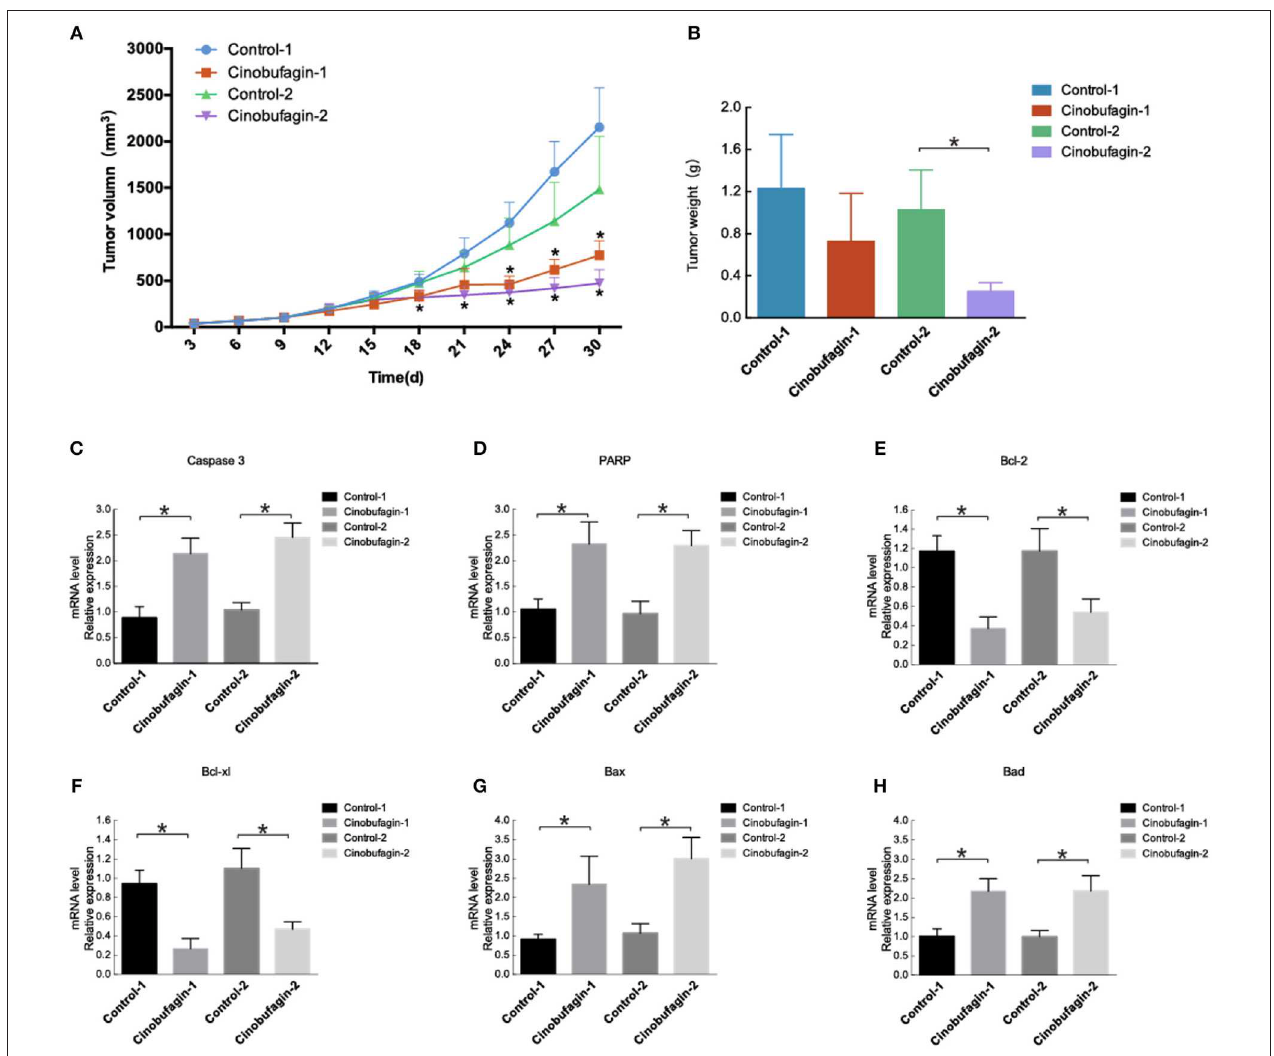
FIGURE 6 | Cinobufagin modulates tumor growth and apoptosis. (A) Nu/Nu nude mice were injected with OCM1 cells. After the tumor size reached 100 mm 3 , the experimental group was intraperitoneally injected with cinobufagin at 5 mg/kg once a day for 10 days (cinobufagin 1). The control group (control 1) was intraperitoneally injected with 0.5 mg/kg saline for 10 days. After the remaining 10 mice had tumors up to 300 mm 3 , the tumors were injected with cinobufagin at 5 mg/kg once a day for 7 days (cinobufagin 2). The control 2 group was untreated (control 2). Tumor volume was measured every 3 days. (B) After 30 days, the mice were killed, and the tumors were removed and analyzed. The tumors treated with cinobufagin weighed less. The expression of (C) caspase-3, (D) PARP, (E) Bcl-2, (F) Bcl-xL, (G) Bad, and (H) Bax was quantified by RT-qPCR in the tumors of the mice. The results are shown as the mean ± SEM of five independent experiments (* P <